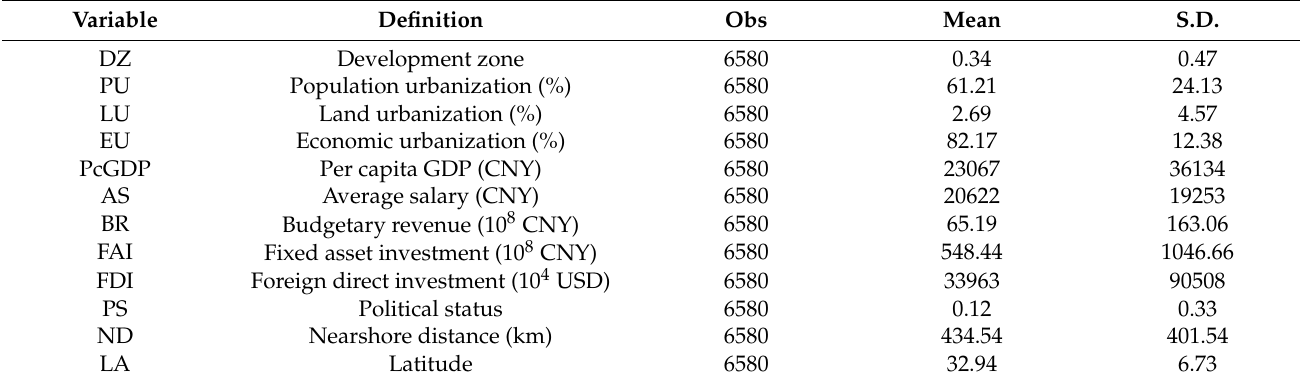
Table 1. Definition and descriptive statistics of